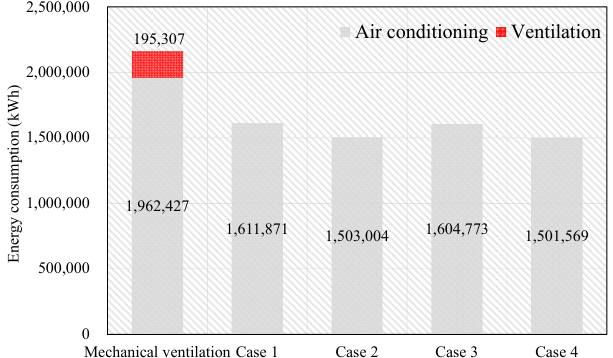
Figure 12. Electric power consumption of VAV and mechanical ventilation fans. The VAV C p value was 3.5, the sensible and latent loads were the same, and the electric power consumption of the heat exchanger was 220 W (the number of hours of use per day was 15 h / day (137 days) / 120 Ea). 270